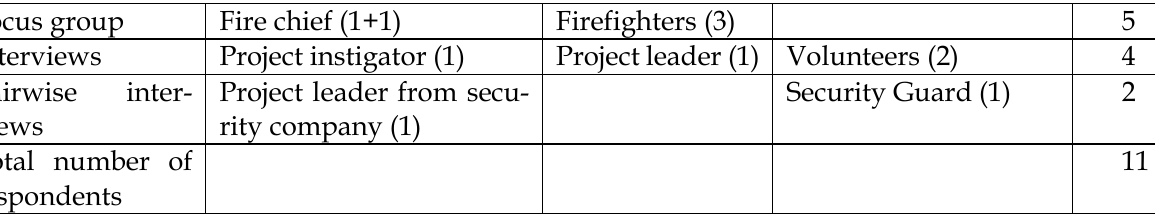
Table 1: Respondents participating in the study.